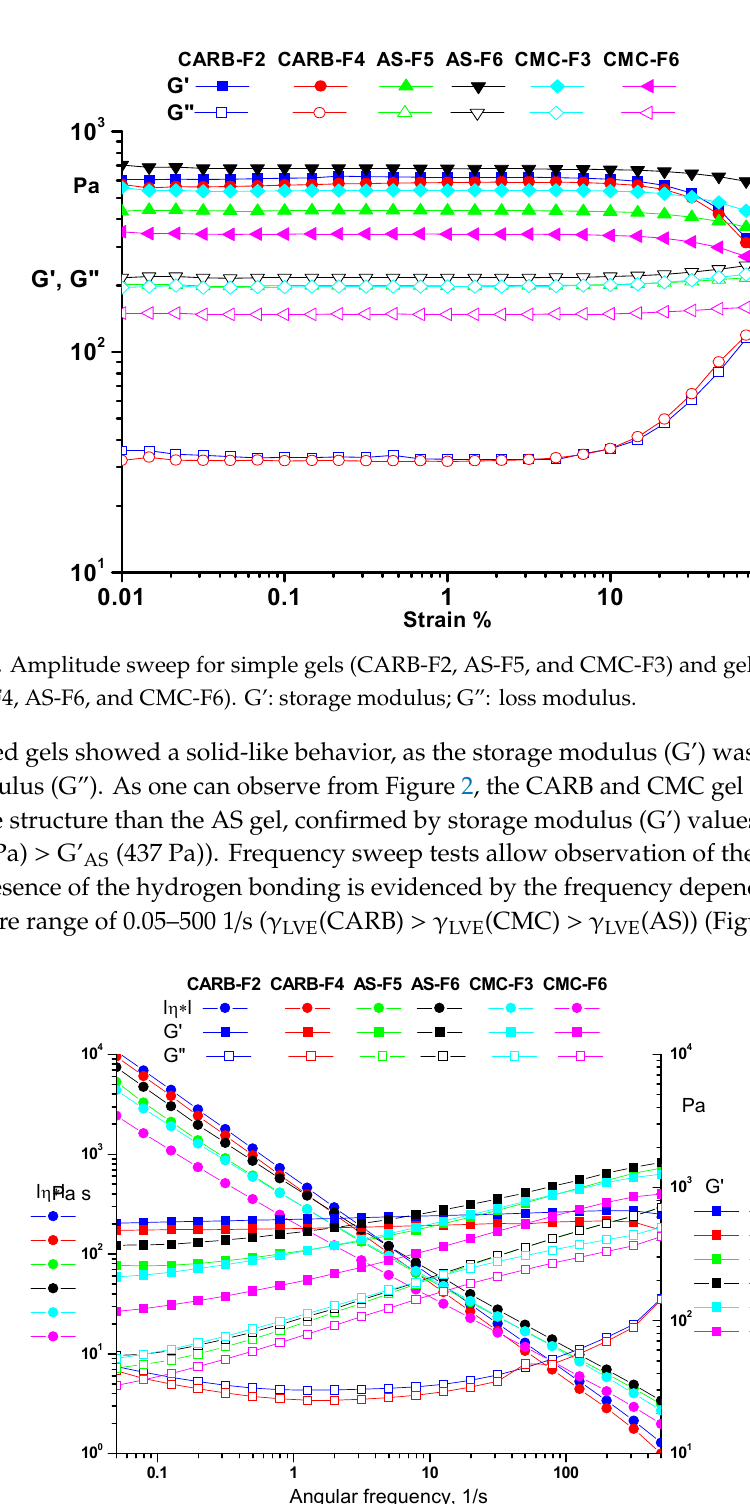
Figure 3. Frequency sweep for simple gels (CARB-F2, AS-F5, and CMC-F3) and gels with CD-NHF (CARB-F4, AS-F6, and CMC-F6).